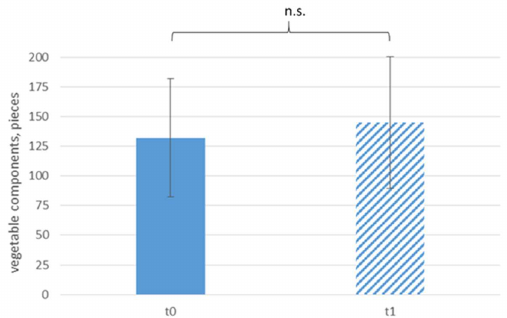
Figure 2. Daily sale of vegetable components according to time; n.s. p > 0.05.